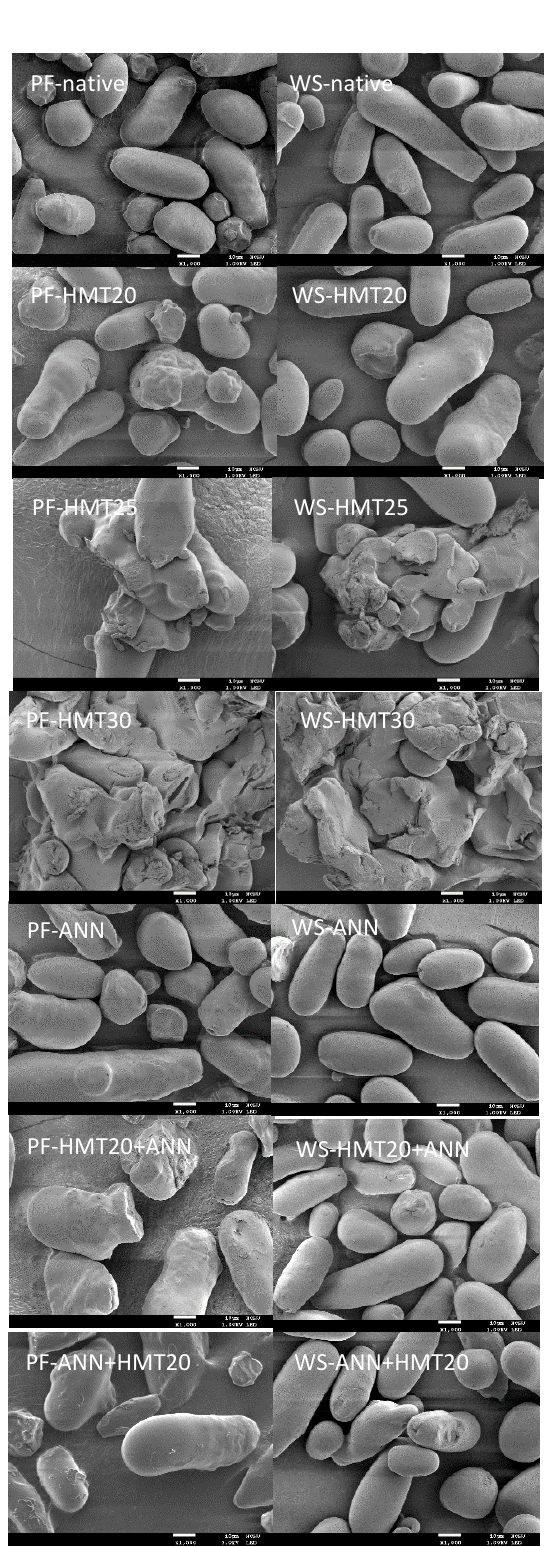
Figure 3. Scanning electron microscopy images of native and modified lotus rhizome starches (1000×).